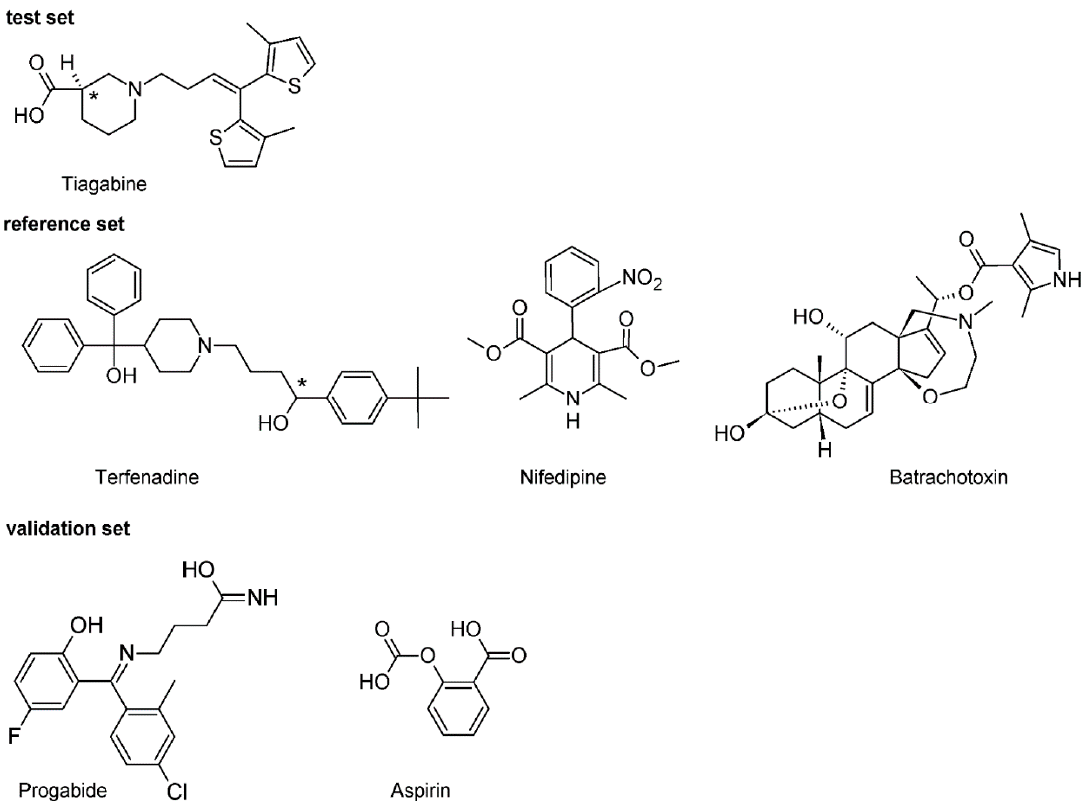
Figure 2. Chemical structure of the investigated compounds. Carbons at a tetrahedral stereogenic center are distinguished by *.